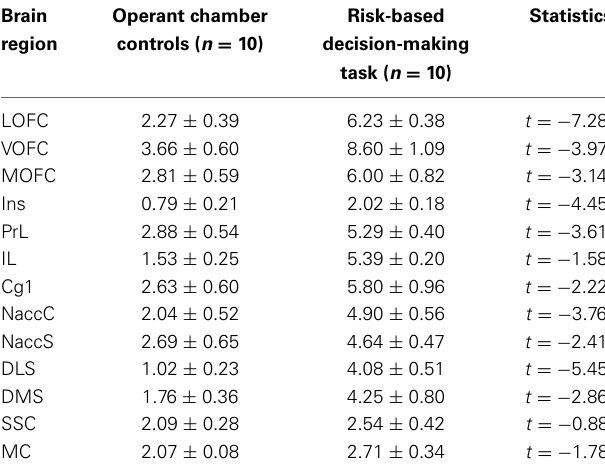
Table 1 | c-fos positive cells by region.